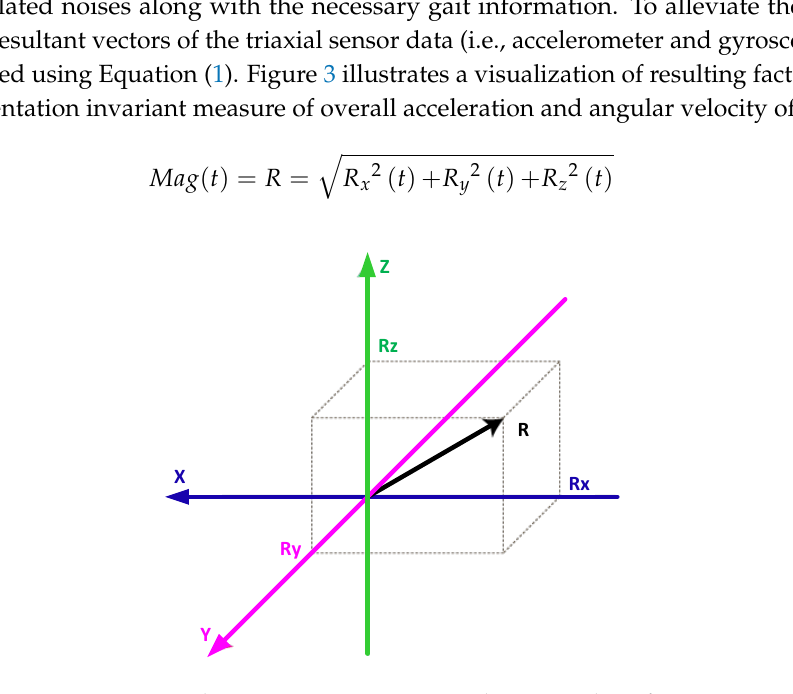
Figure 3. Resulting Factor Extraction. R indicates resulting